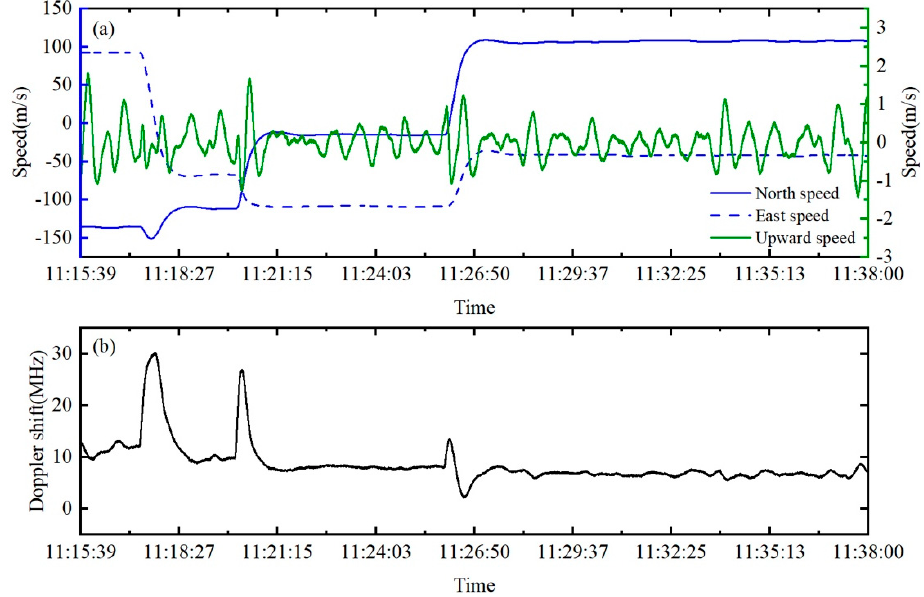
Figure 7. The Doppler shift of the laser pulse during the flight campaign .